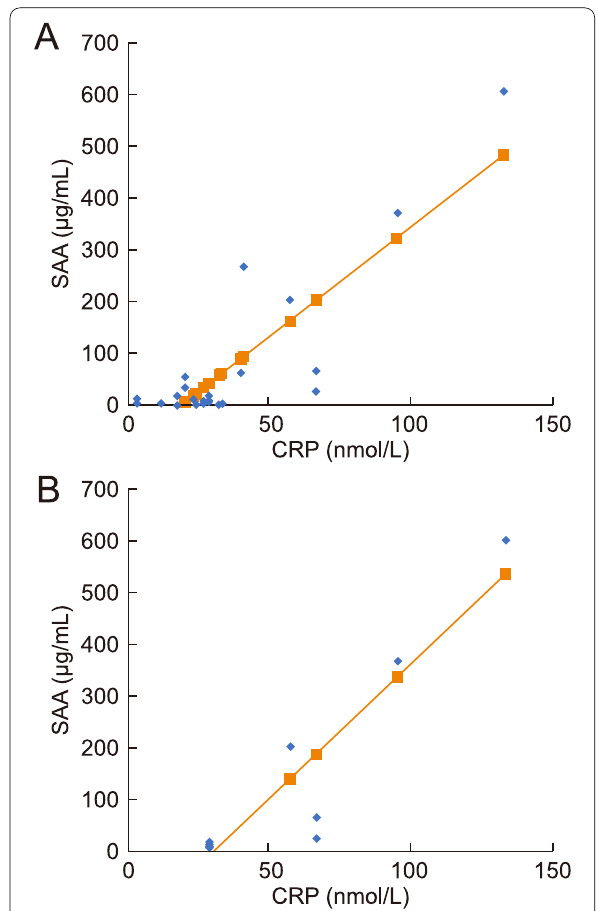
Fig. 2 Linear regression between vCRP and vSAA concentrations. A Feline carnivores. Simple regression analysis: y 4.2038x – 80.9082. = Correlation coefficient r 0.8572 ( n 28). B Lions. Simple regression = = analysis: y 5.2456x – 162.623. Correlation coefficient r 0.9279 ( n = = =